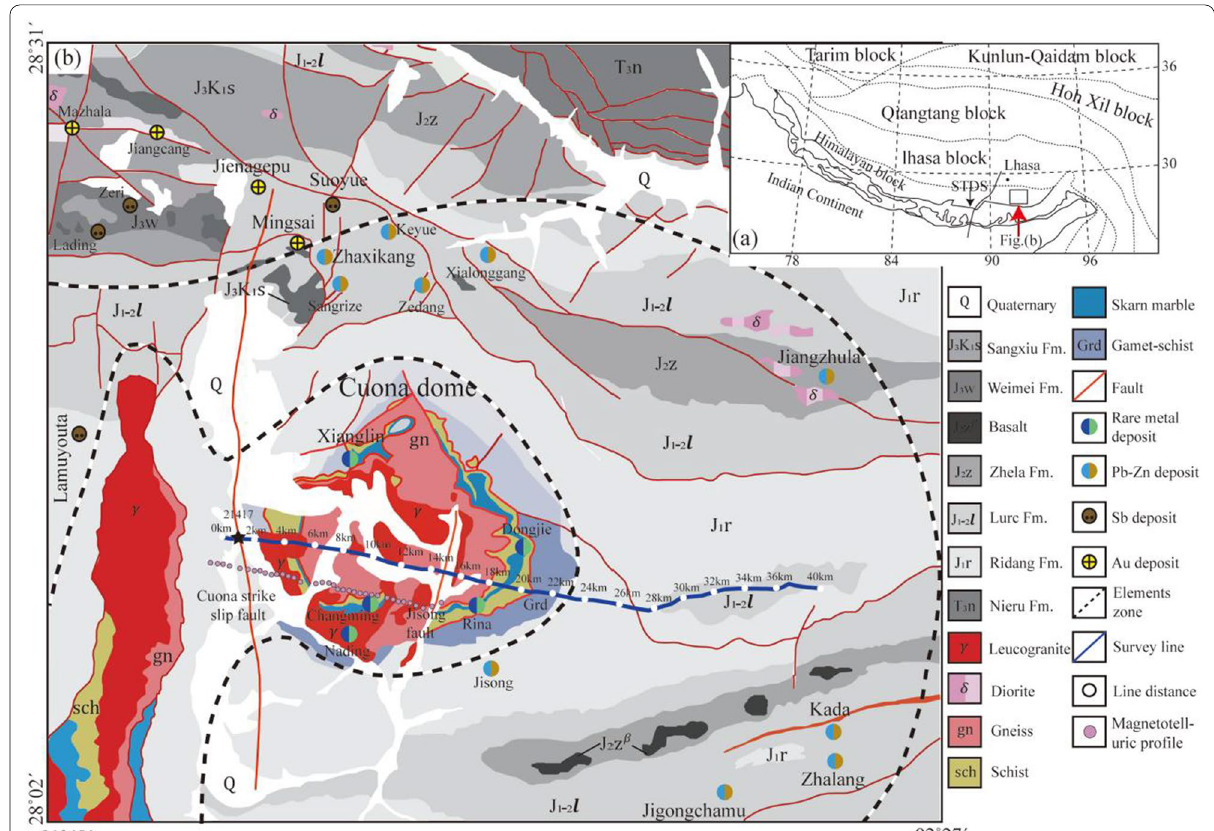
Fig. 1 a Sketch map of the Tibetan Plateau and its surrounding terranes. b Geologic and ore deposit distribution map of the Zhaxikang Pb–Zn polymetallic ore-concentration area (modified from Liang et al.